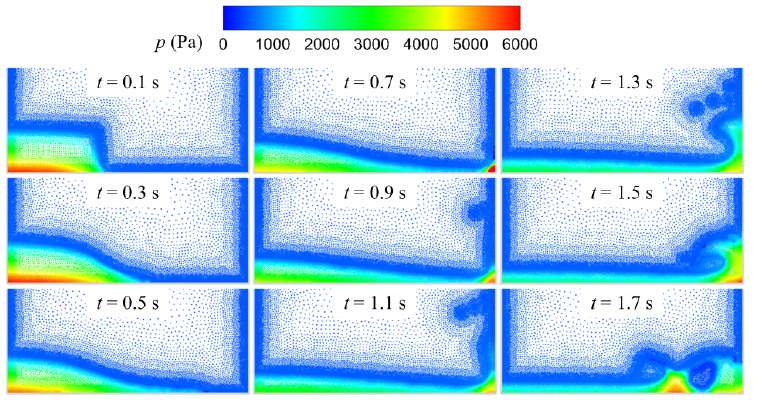
Figure 8. Simulations of dam-break flows based on the SPH-ASR technique